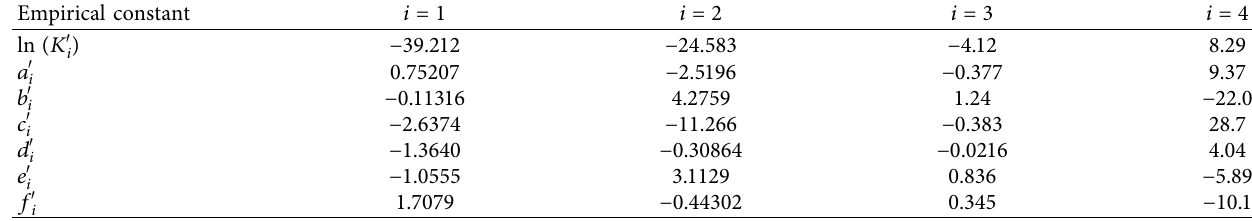
Figure 16: Comparisons of experimental and predicted results for the effect of particle size on R (t) [37] (a) 2D gas-injection condition (b) 3D gas-injection Table 3: Empirical constants determined for the models of mound and bed heights [43, 46].